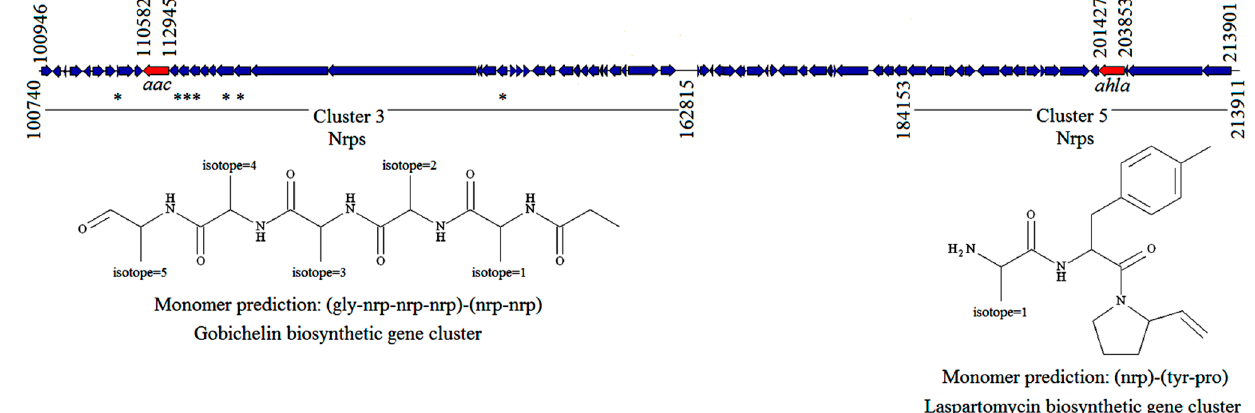
Figure 1. Clusters 3 and 5 within the contig 8-containing aac and ahla genes (highlighted in red), and rough prediction of core scaffolds produced by those clusters based on assumed PKS/NRPS collinearity without considering tailoring reactions. Genes highlighted with asterisks are related to ABC-transporter systems. The predicted gene clusters contain the domain annotations and the prediction of putative core structures. In both cases, the role of these acylases seems to be relevant in the synthesis of nonribosomal peptides.